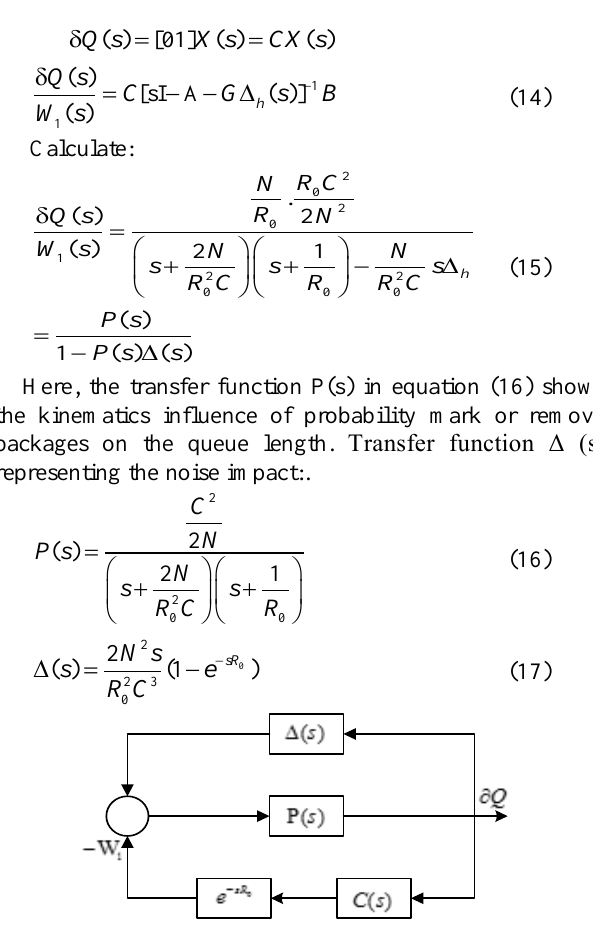
Figure 6. The control system feedback